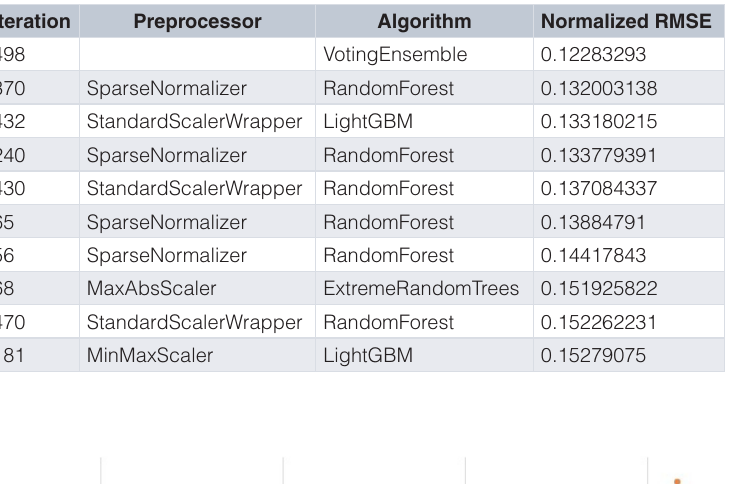
Table 6. Top 10 training iterations of the IC Mean Squared Error. Note that the top performing model (VotingEnsemble) is the final IC model discussed in this paper. 50